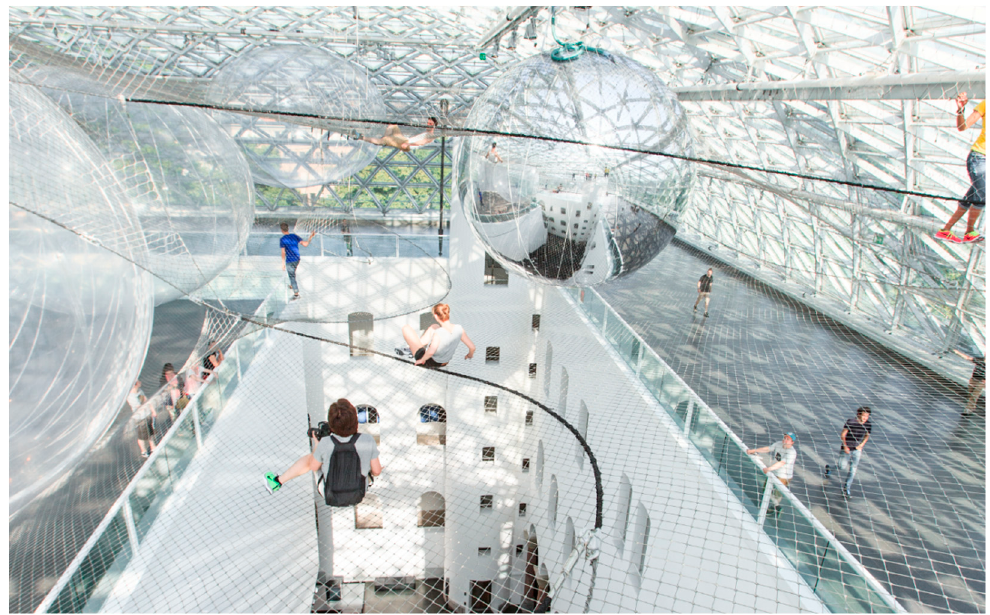
Figure 1. Tomás Saraceno, In Orbit, 2013. Solo exhibition at Kunstsammlung Nordrhein-Westfalen, K21 Ständehaus, Düsseldorf, Germany. Curated by Marion Ackermann and Susanne Meyer-Büser. Courtesy the artist; Tanya Bonakdar Gallery, New York; Andersen’s Contemporary, Copenhagen; Ruth Benzacar Galería de Arte, Buenos Aires; Pinksummer contemporary art, Genoa; Esther Schipper, Berlin. © Photography by Studio Tomás Saraceno, 2013.